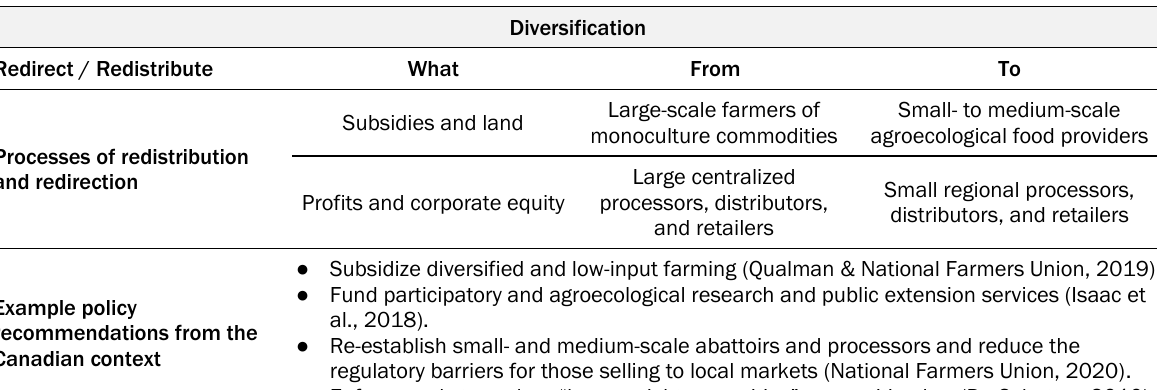
Table 3. Examples of Redistributive Policies Supporting